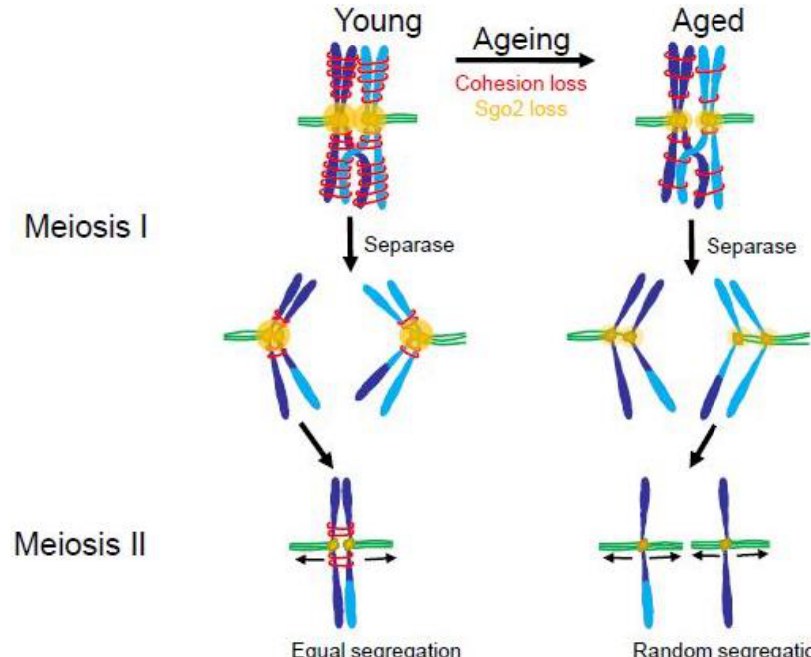
Figure 7. Loss of cohesin and the cohesin protector, Sgo2, in older mammals may lead to increased premature chromatid separation in meiosis. In young mammals (left) paired homologous chromosomes have high levels of cohesin and Sgo2 in Meiosis I (MI). At anaphase of Meiosis I, the protease, Separase, clips Cohesin on the distal chromosome arms allowing the homologous chromosomes to separate. Sgo2 protects Cohesin near the centromeres until Meiosis II (MII) ensuring that sister chromatids will orient to opposite poles. In aged mammals (right) there are diminished amounts of Cohesin and Sgo2. During Meiosis 1 Separase cleaves the majority of cohesin, including that near the centromeres. This allows sister chromatids to separate during anaphase of Meiosis I. In Meiosis II the individual chromatids may separate randomly to the spindle poles leading to a high incidence of aneuploidy. (Adapted from [163].)